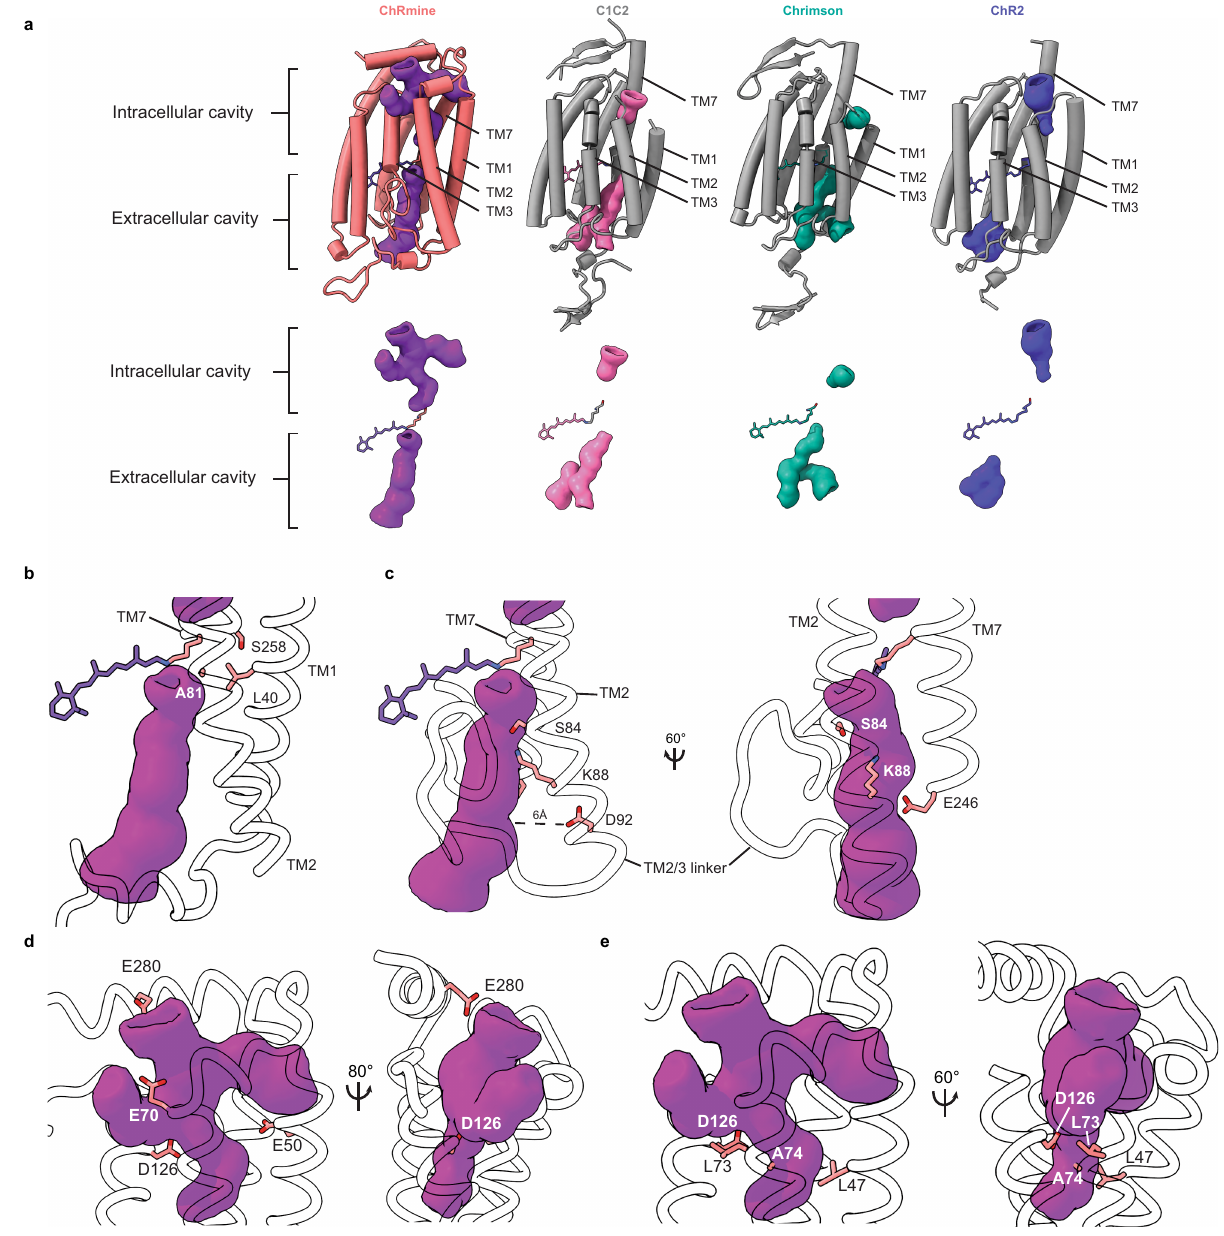
Fig. 3 | The ChRmine ion conduction pathway. a Ion conducting pathways in ChRmine, C1C2, Chrimson, and ChR2. A single subunit is shown with helices as tubes(upper).Surfacesofionconductingpathwaysarepurple,pink,green,orblue.